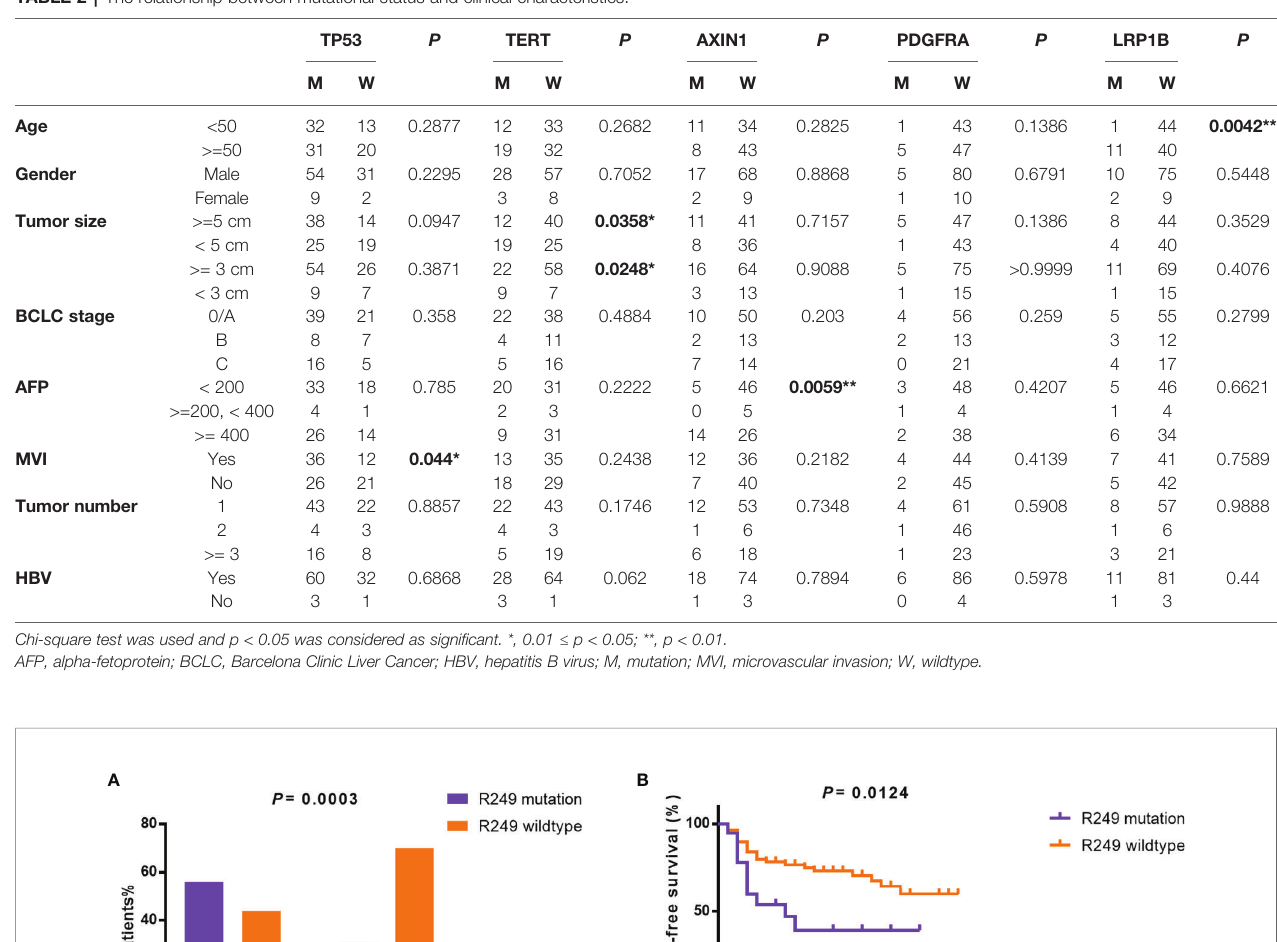
TABLE 2 | The relationship between mutational status and clinical characteristics.